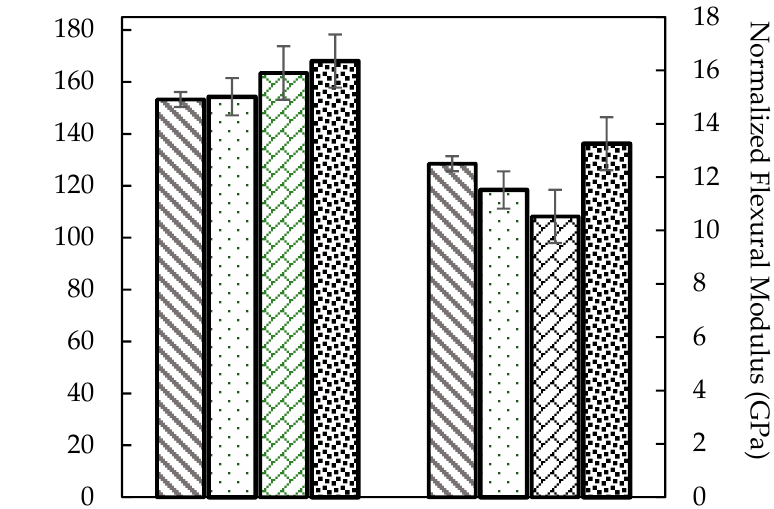
Figure 4. Normalized fleaxural strength and flexural modulus of untreated and treated flax/VE composites.